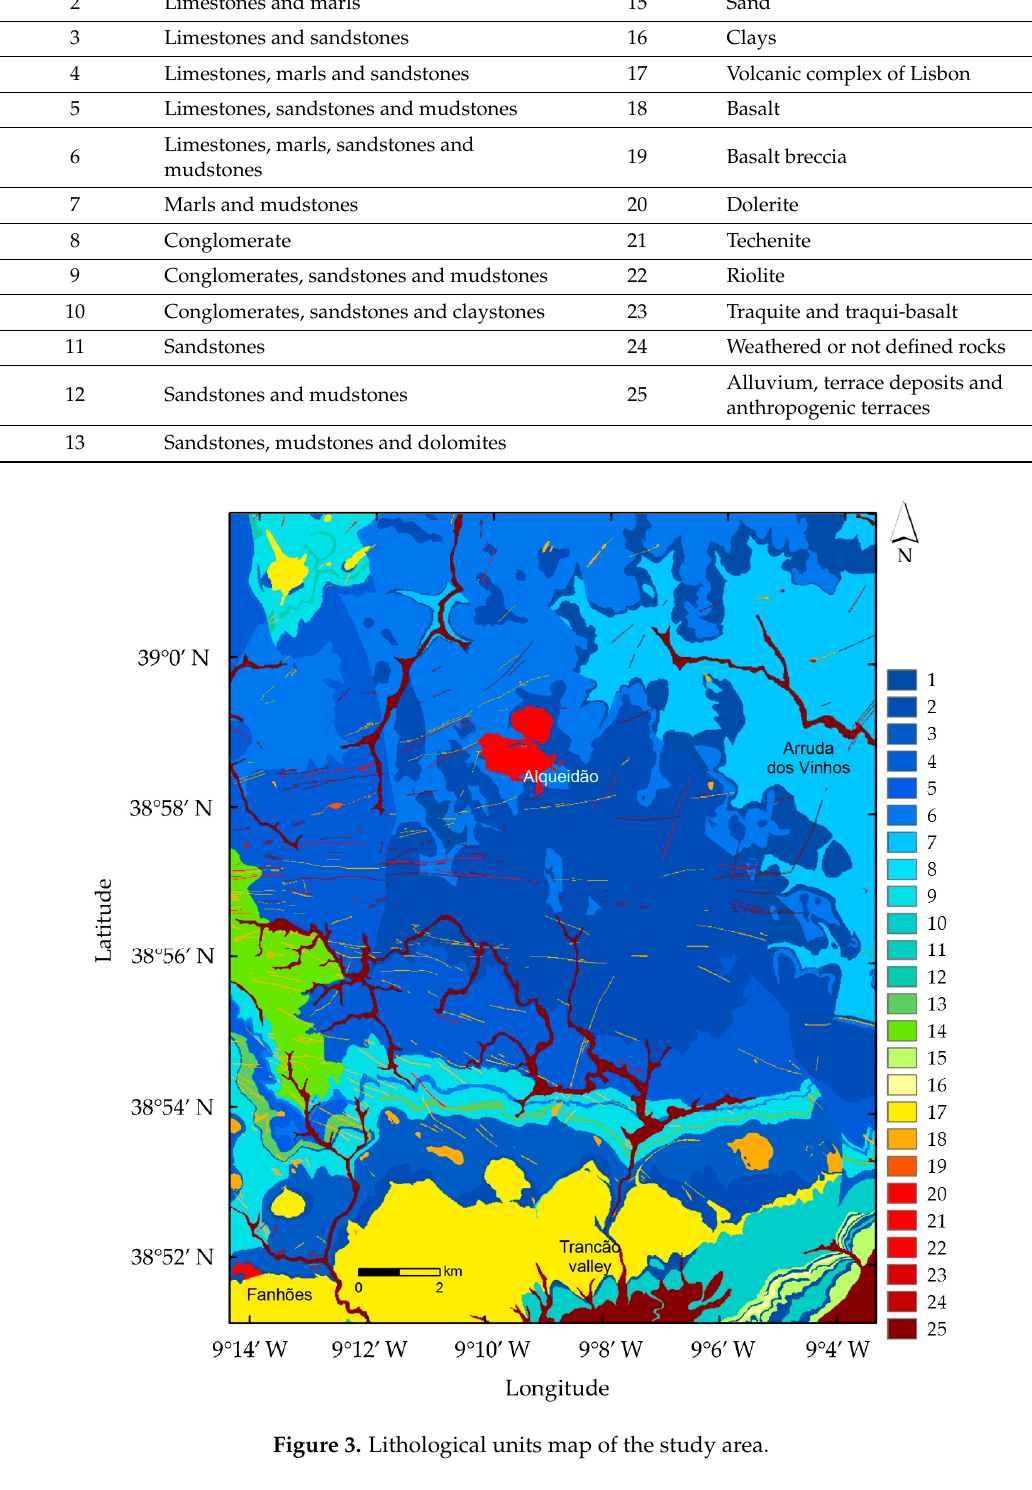
Table 2. Lithological Units.